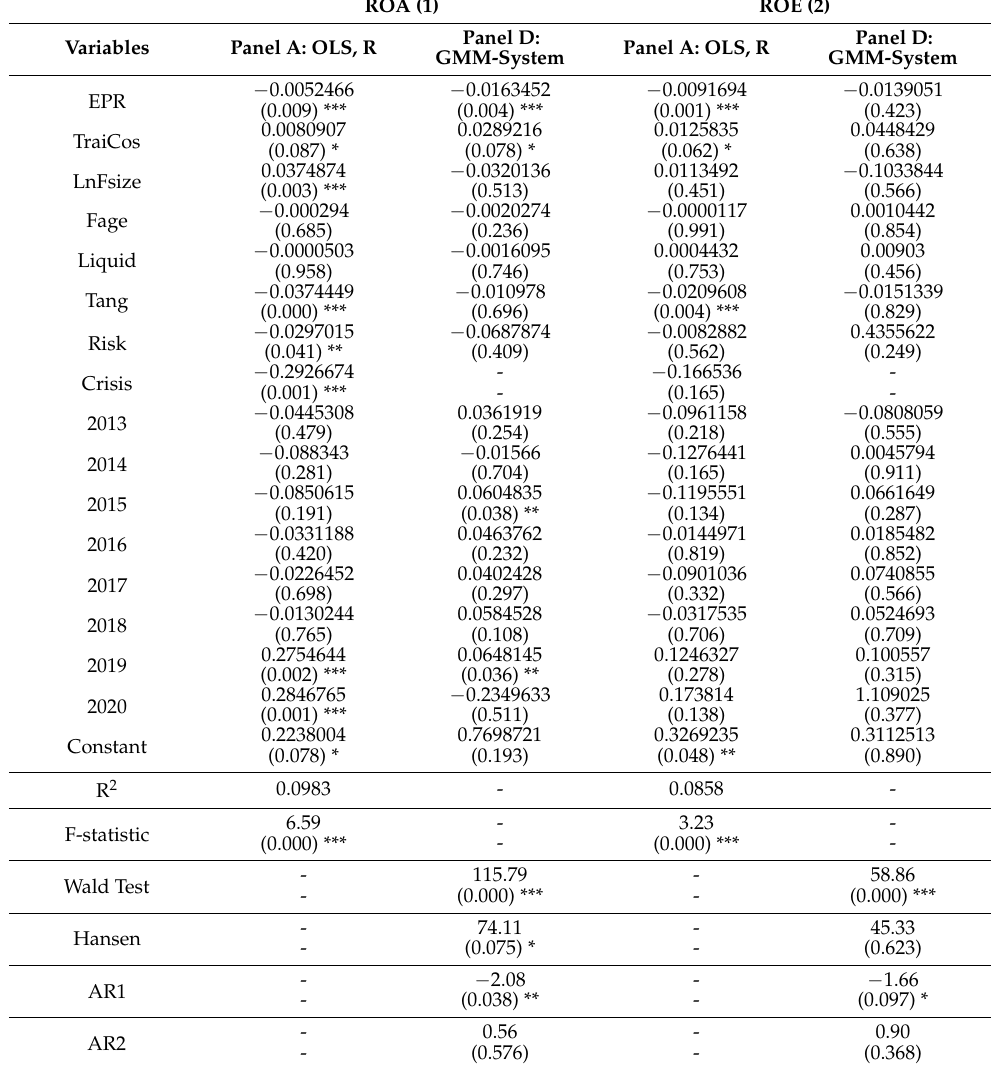
Table 5. Regression analysis of model (1) and